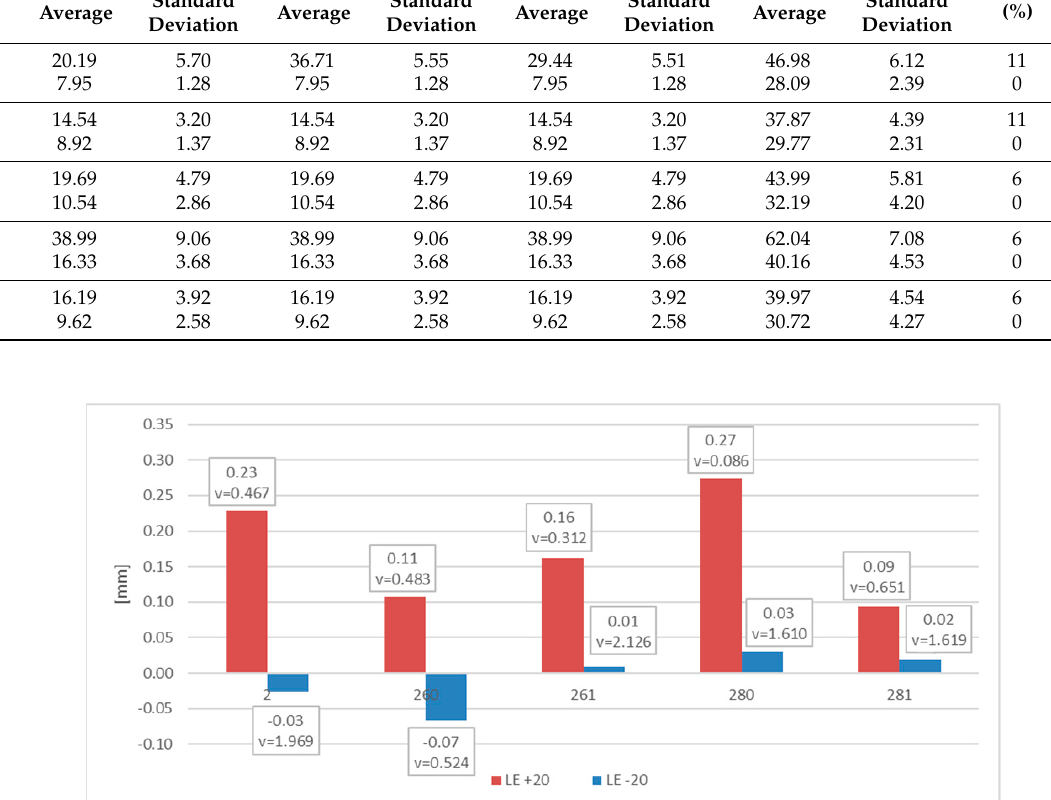
Table 5. Values of the SFA ( n ) (%) parameters determined for X20Cr13 steel, determined on impact